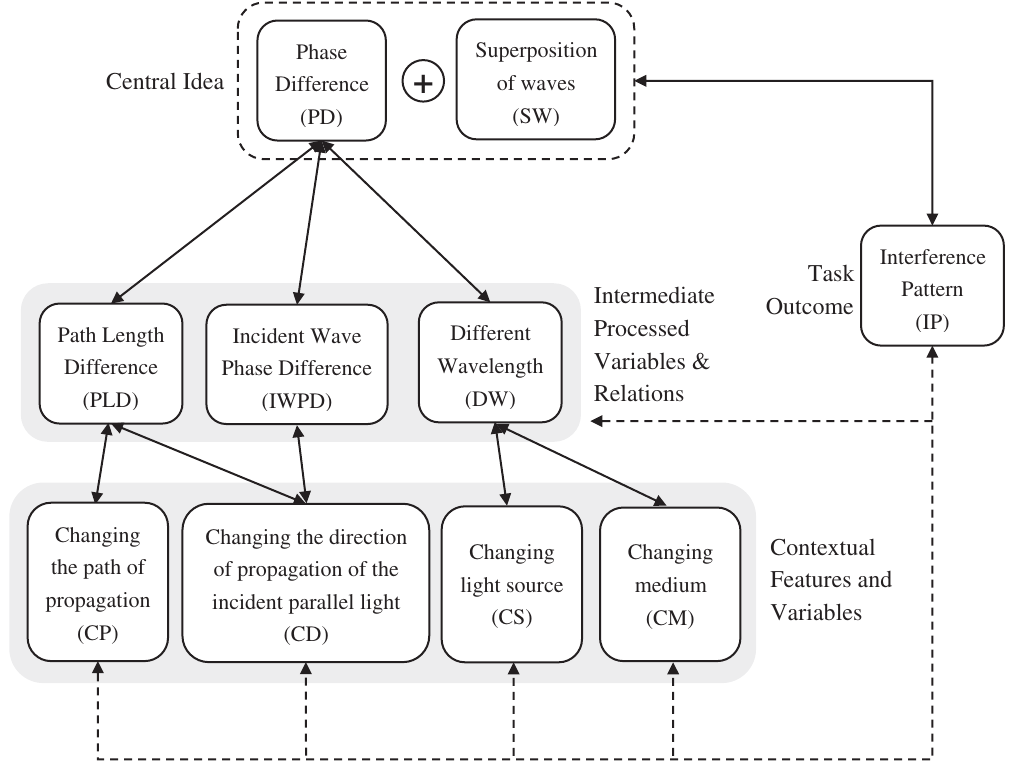
FIG. 1. Conceptual framework of light interference. Solid arrows represent the desired reasoning pathways that experts made among knowledge pieces to aid problem solving, while the dashed arrow represent the direct links between contextual features and the task outcomes that novices often made. The abbreviations within the parentheses are used to label that knowledge piece, which will be referenced in later discussion on the related